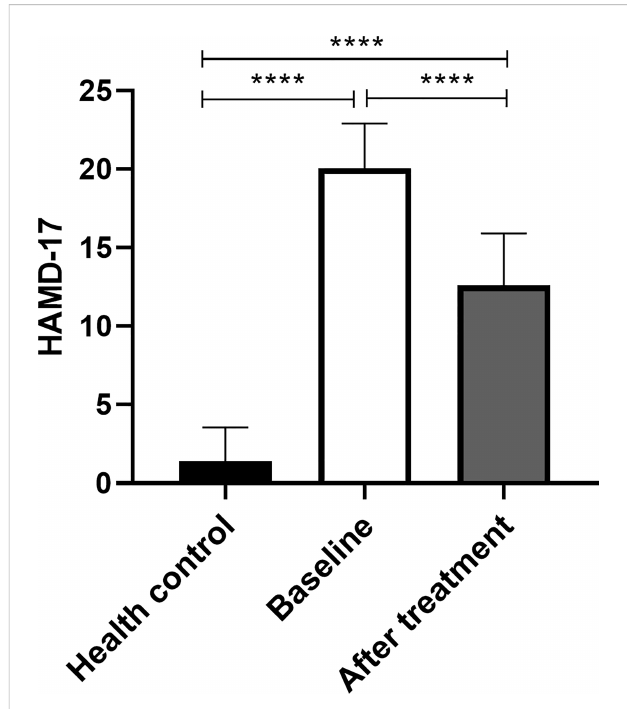
FIGURE 3 HAMD-17: 17-item Hamilton Depression Rating Scale. ****p<0.01.